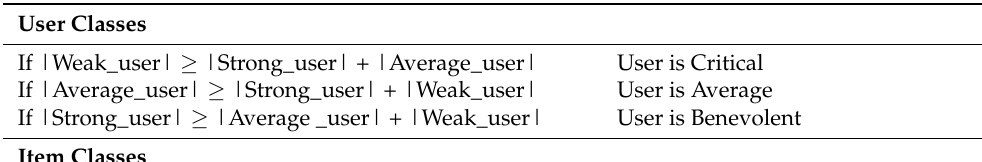
Table 3. User, Item and Rating